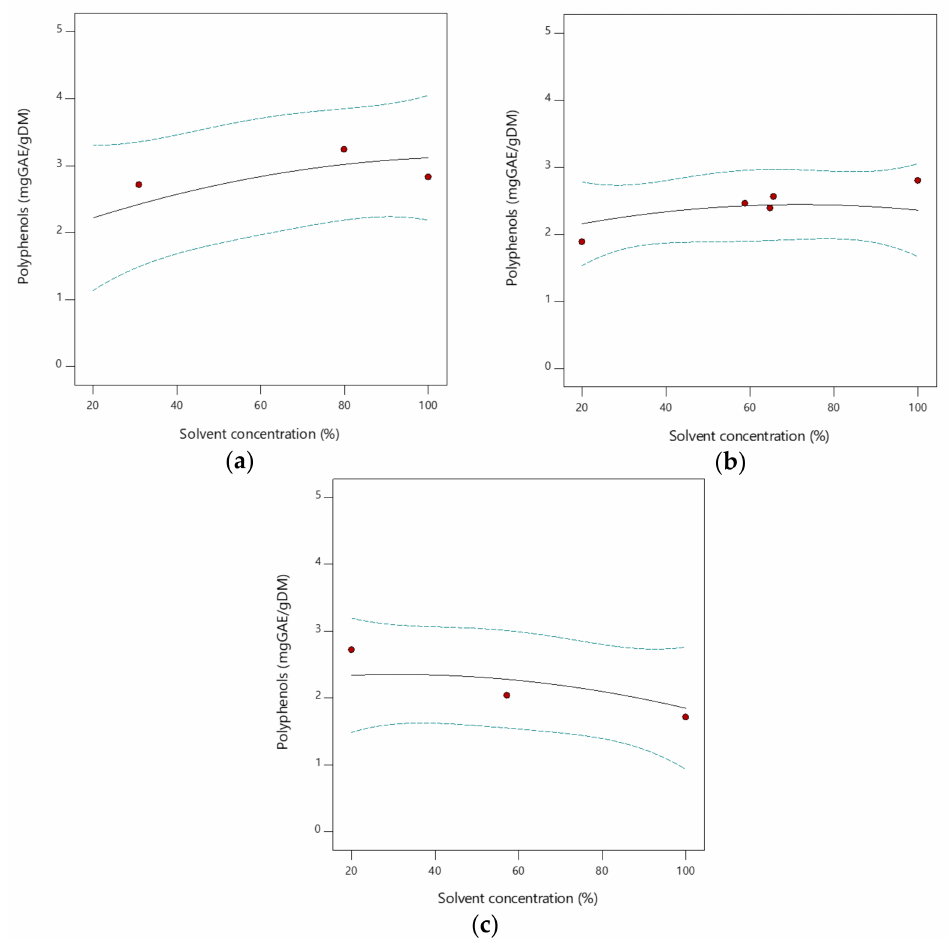
Figure 2. Dependence of response variable (total phenols, mg GAE /g DM ) from solvent concentration (solid line) with the indication of the 95% confidence interval bands (dashed lines) and experimental design points (red circles), using ( a ) acetone, ( b ) ethanol and ( c ) methanol as organic